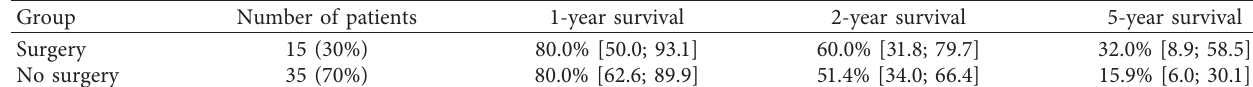
Figure 1: Survival results depending on the number of brain metastases ( p � 0 . 02). Table 6: Survival results of the patients treated by surgery.